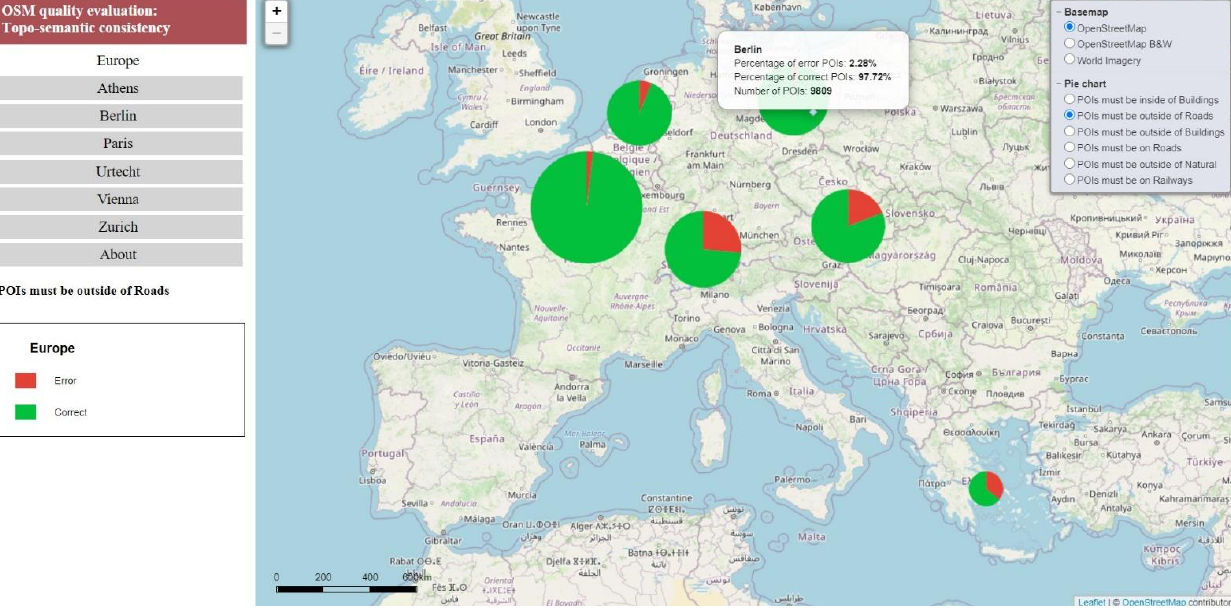
Figure A1. At the regional level, topo-semantic errors for “POIS must be outside of roads” are portrayed with a pie chart for each city.